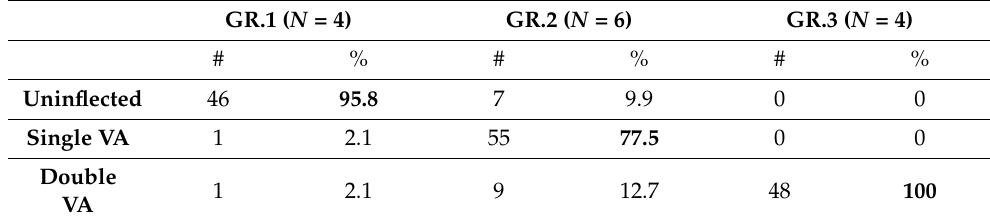
Table 3. Results of individuals from Chic á n grouped according to the main strategy used in the